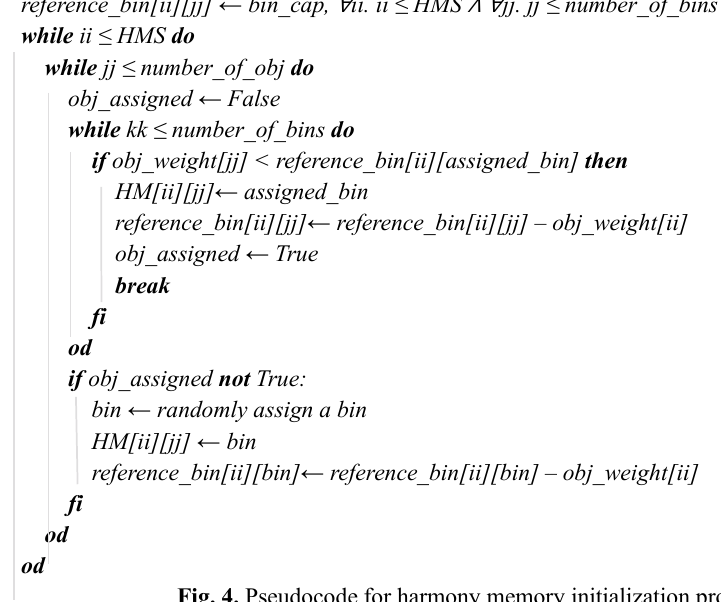
Fig. 4. Pseudocode for harmony memory initialization procedure 2